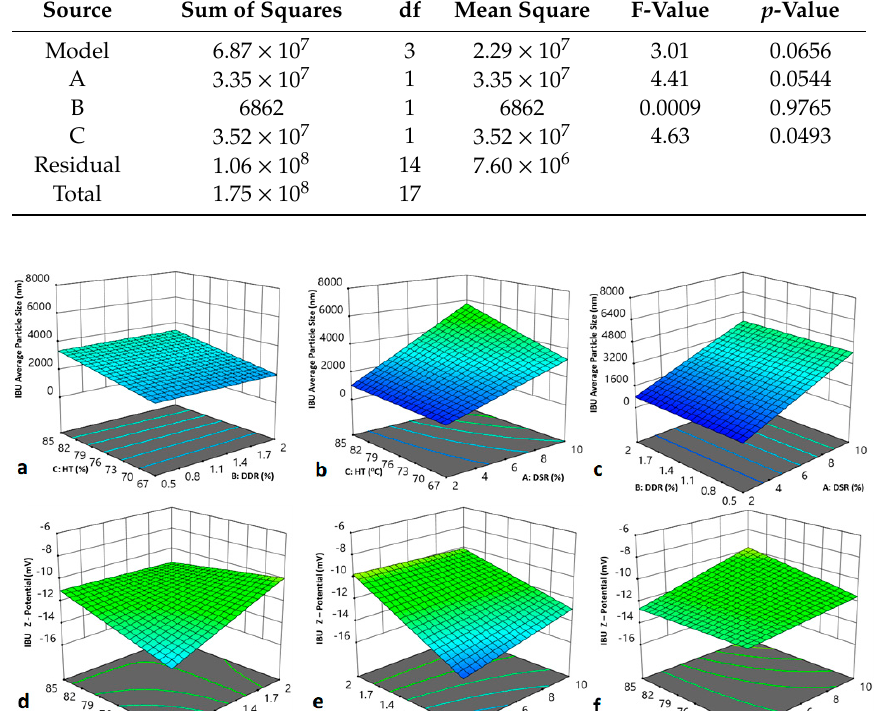
Table 6. Analysis of variance for the statistical significance of the investigated factors (A: drug to stabilizer ratio, B: drug to mannitol ratio, C: inlet temperature) on the particle diameter after redispersion of the suspensions.